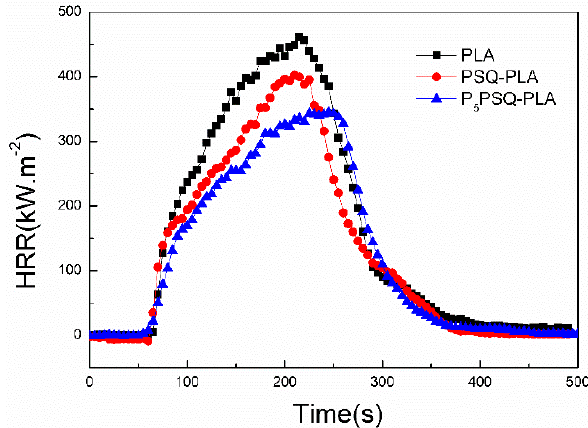
Table 2. LOI value and CCT data for neat PLA and its flame retardant composites.